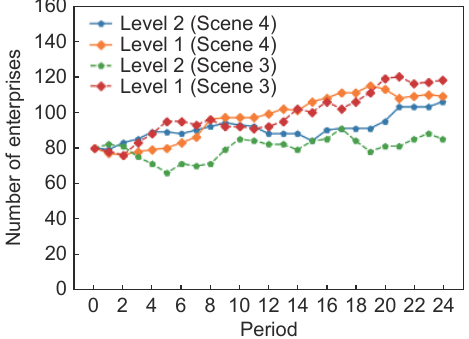
Fig. 12 Scenes 3 and 4: Changes of number of enterprises in Levels 1 and 2.